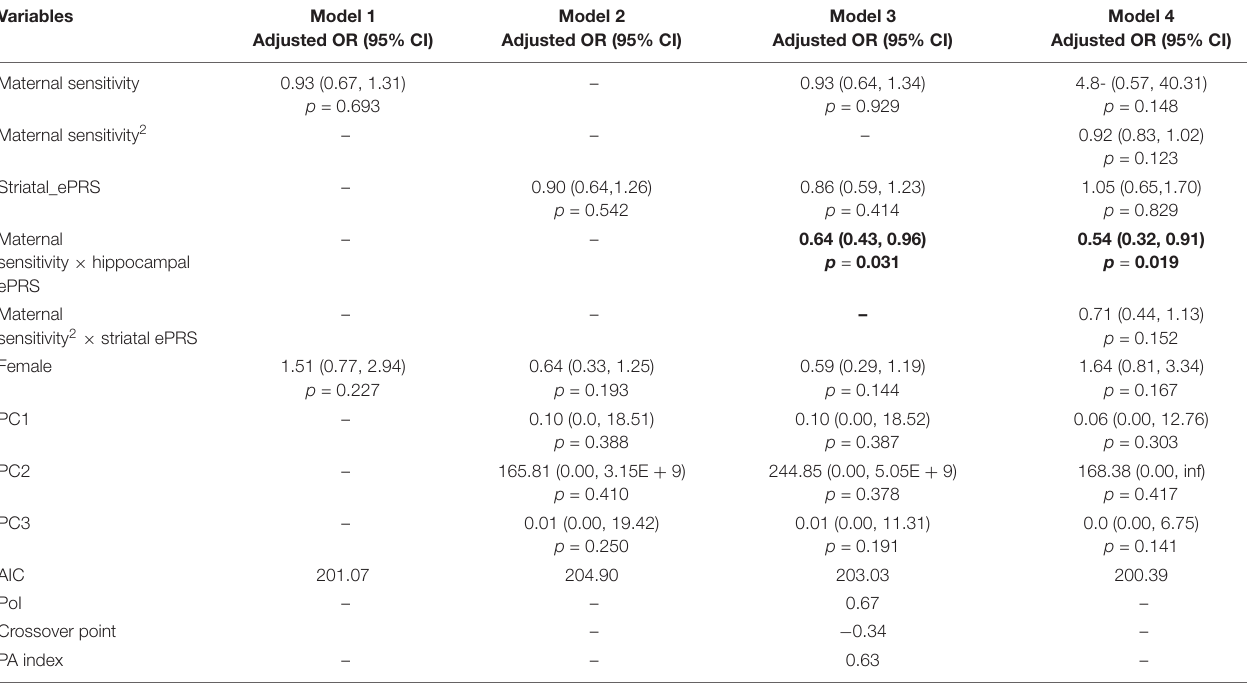
TABLE 3 | Associations among maternal sensitivity, striatal gene network for CNR1ePRS, covariates, and secure vs. insecure attachment